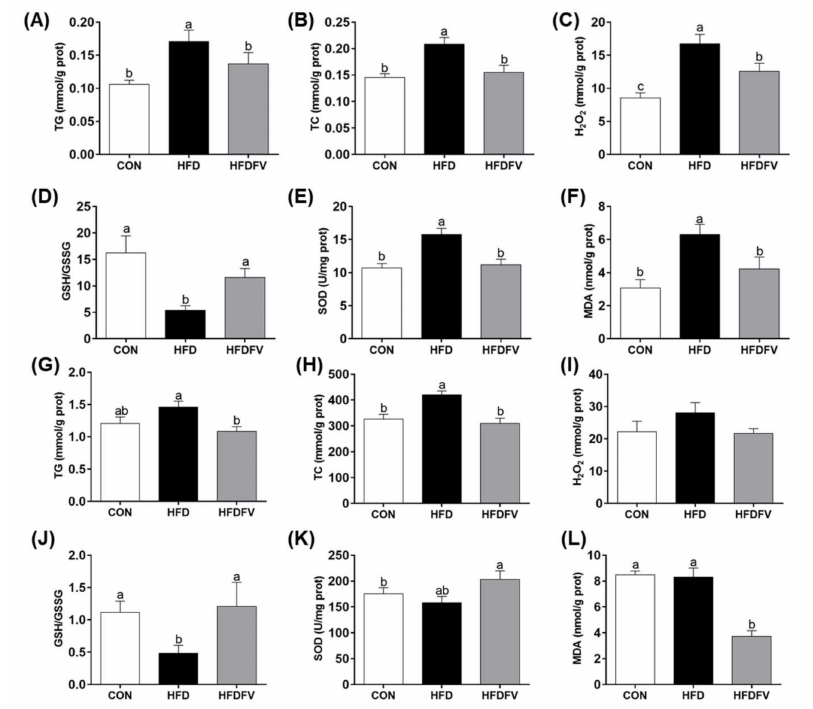
Figure 3. Effect of FV mycorrhizae on the lipids content and oxidative stress parameters in the liver and PAT of mice. ( A – F ) Lipid content and oxidative stress parameters in the liver; ( G – L ) Lipid content and oxidative stress parameters in the PAT. TG, triglyceride; TC, total cholesterol. Values with different letters differ significantly (p < 0.05). Values were expressed as mean ± SEM (n =